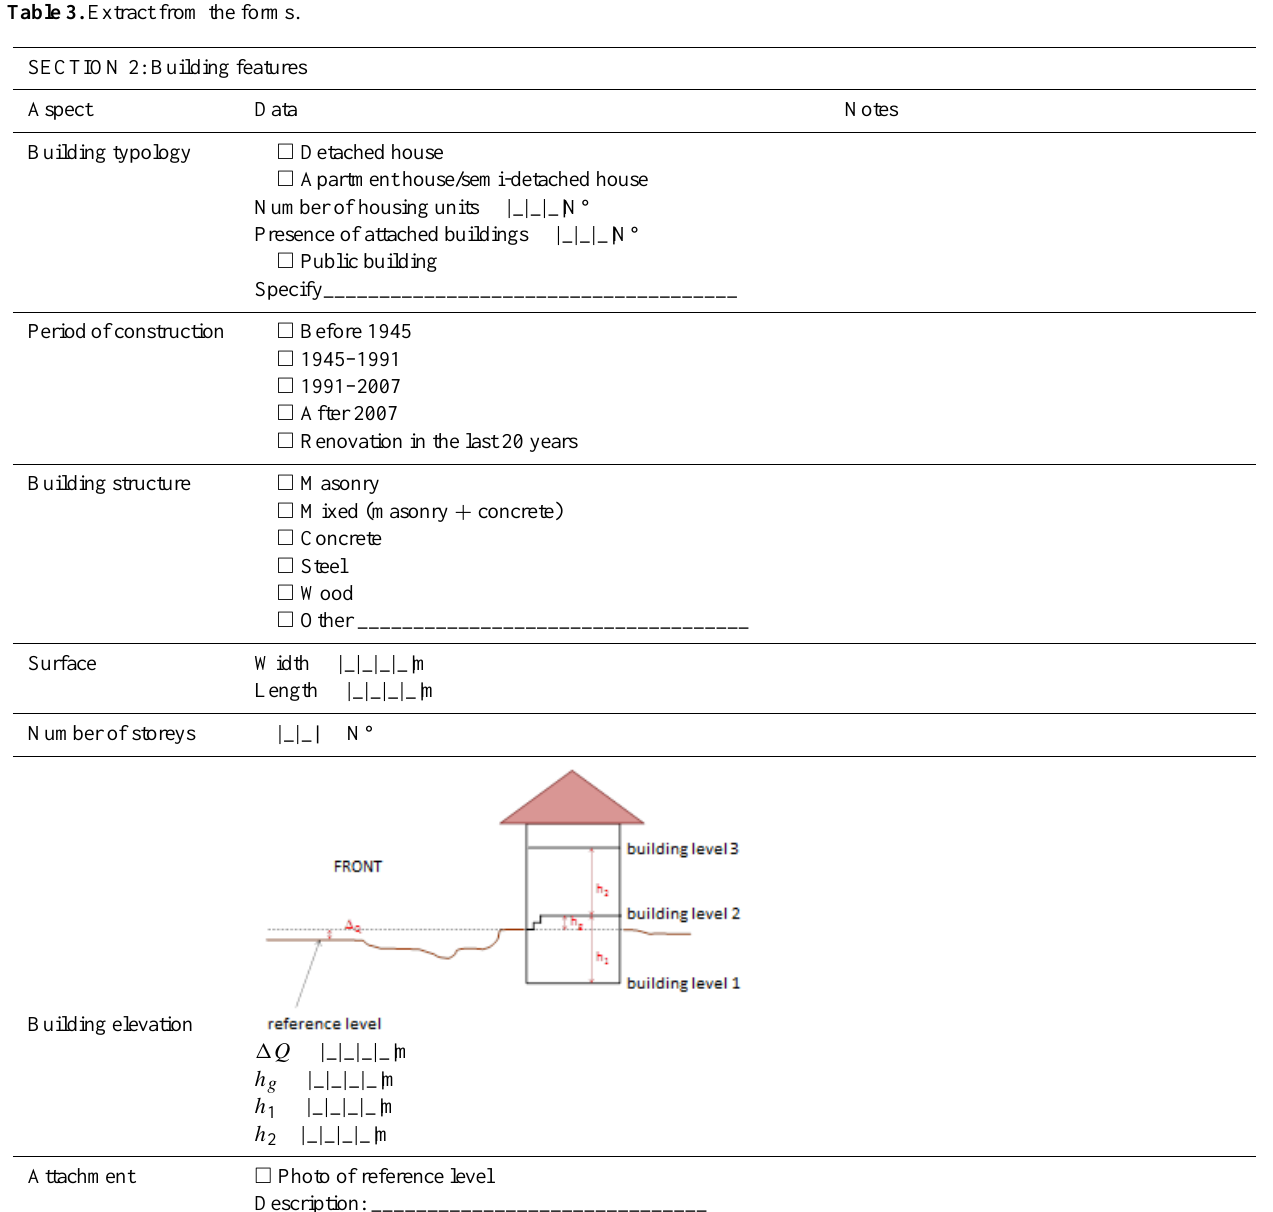
Table 3. Extract from the forms. Note the possibility of validating known data.